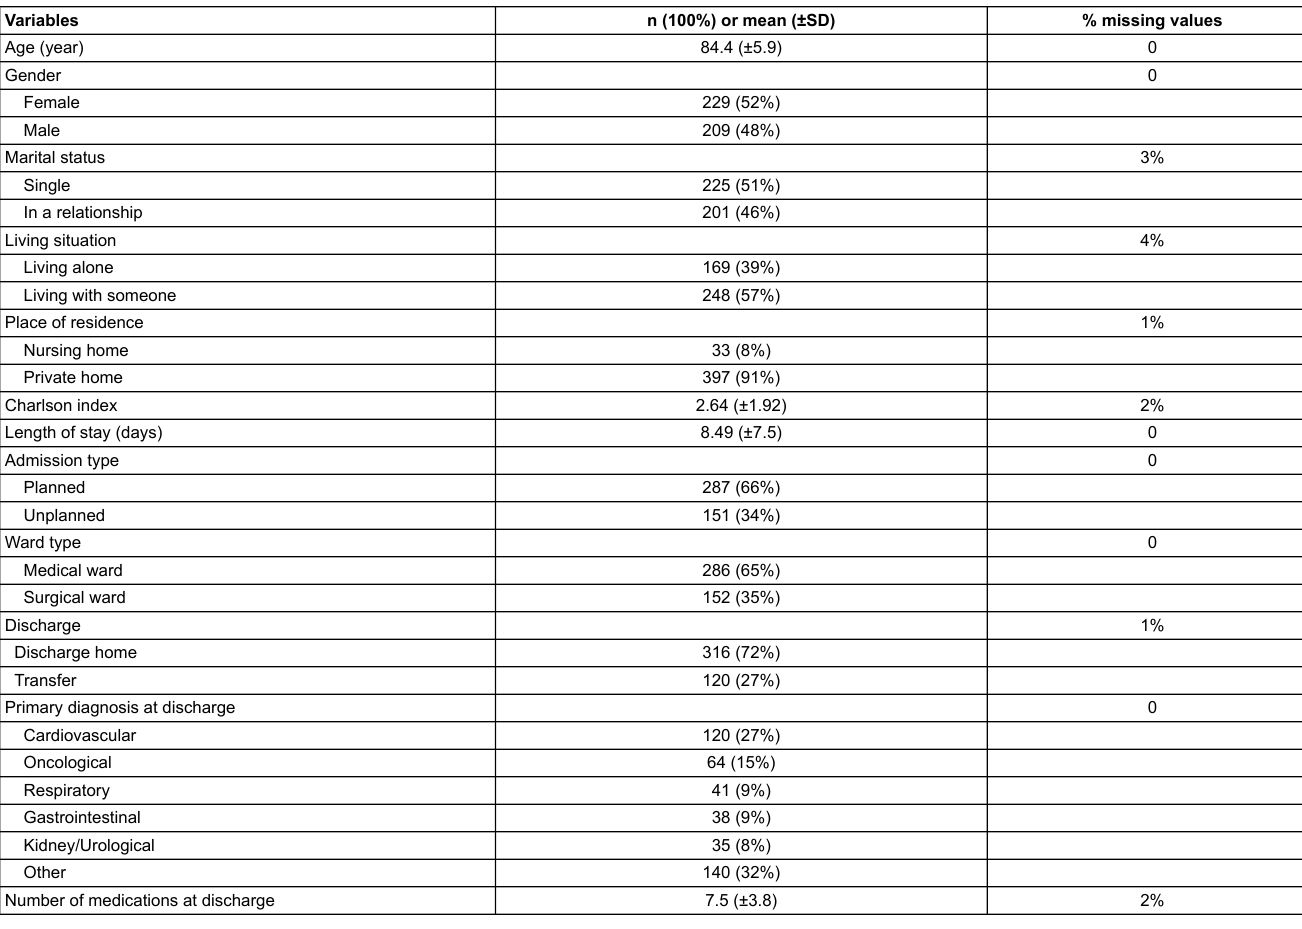
Table 3: Patient